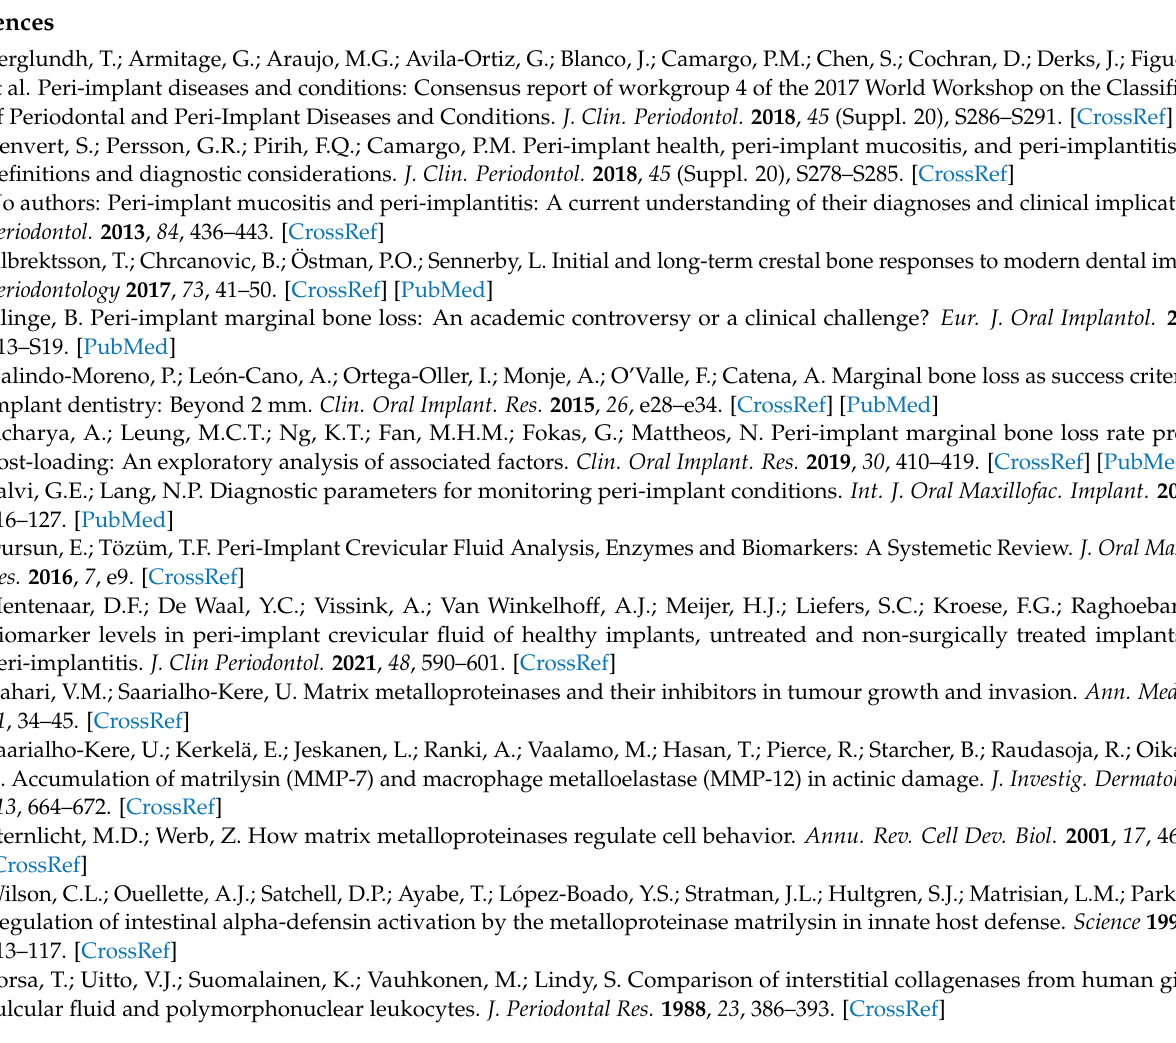
Figure A1. The CONSORT Flow Diagram.References